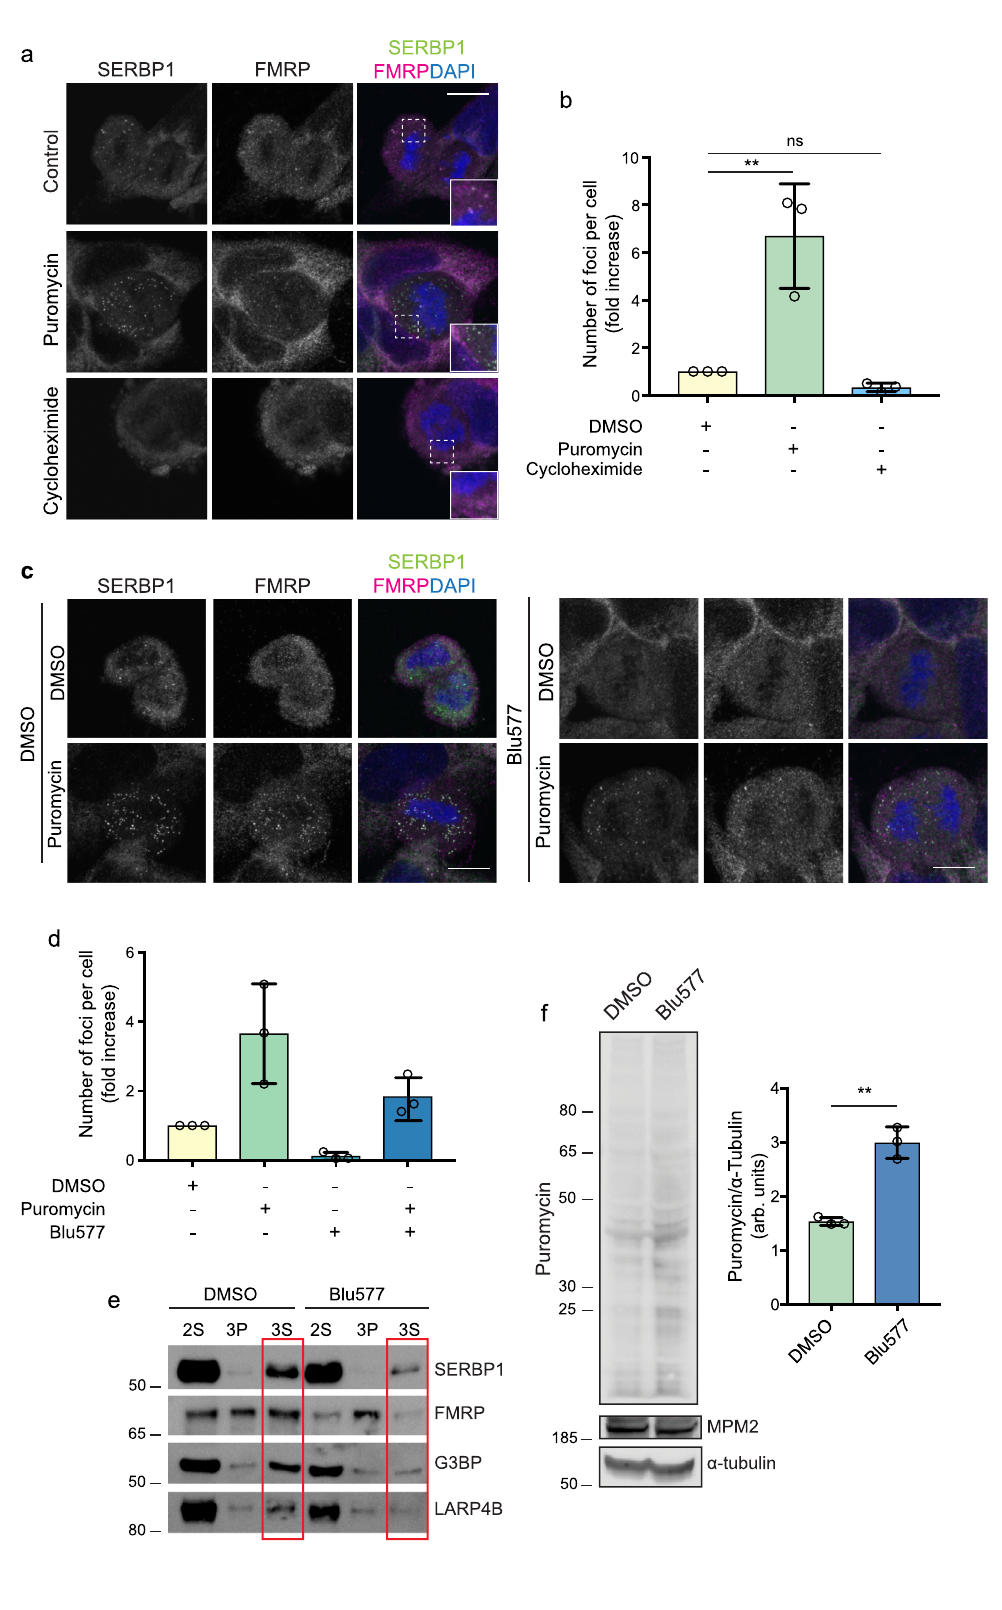
anti-PKC ε pSer substrate (Cell Signalling Technology (2261), 1:1000), mouse anti- GAPDH (Millipore (MAB374), 1:5000), mouse anti-Myc (Cell Signalling Tech- nology (2276), 1:2000), mouse anti-FLAG M2 (Sigma (B3111), 1:2000), rabbit anti- SERBP1 (Abcam (55993), 1:1000), mouse anti- α -tubulin (in house, 1:1000), mouse anti-PABP (Santa Cruz (sc-166027), 1:1000), mouse anti-FMRP (Millipore (MAB2160), 1:1000), rabbit anti-LARP4B (Novus Biologicals